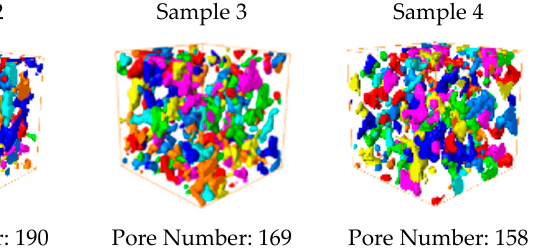
Figure 8. Calibration chart of pore separation.